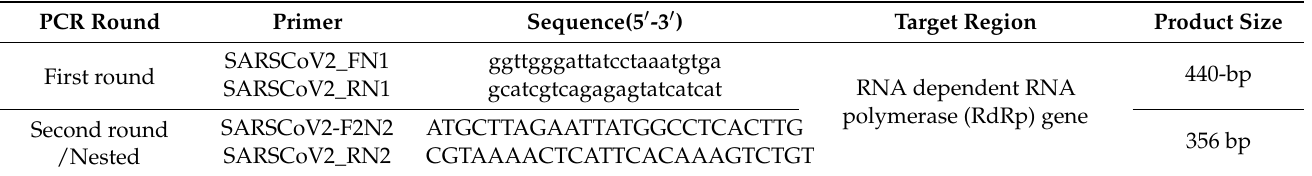
Table 2. Oligonucleotides used in RT-PCR